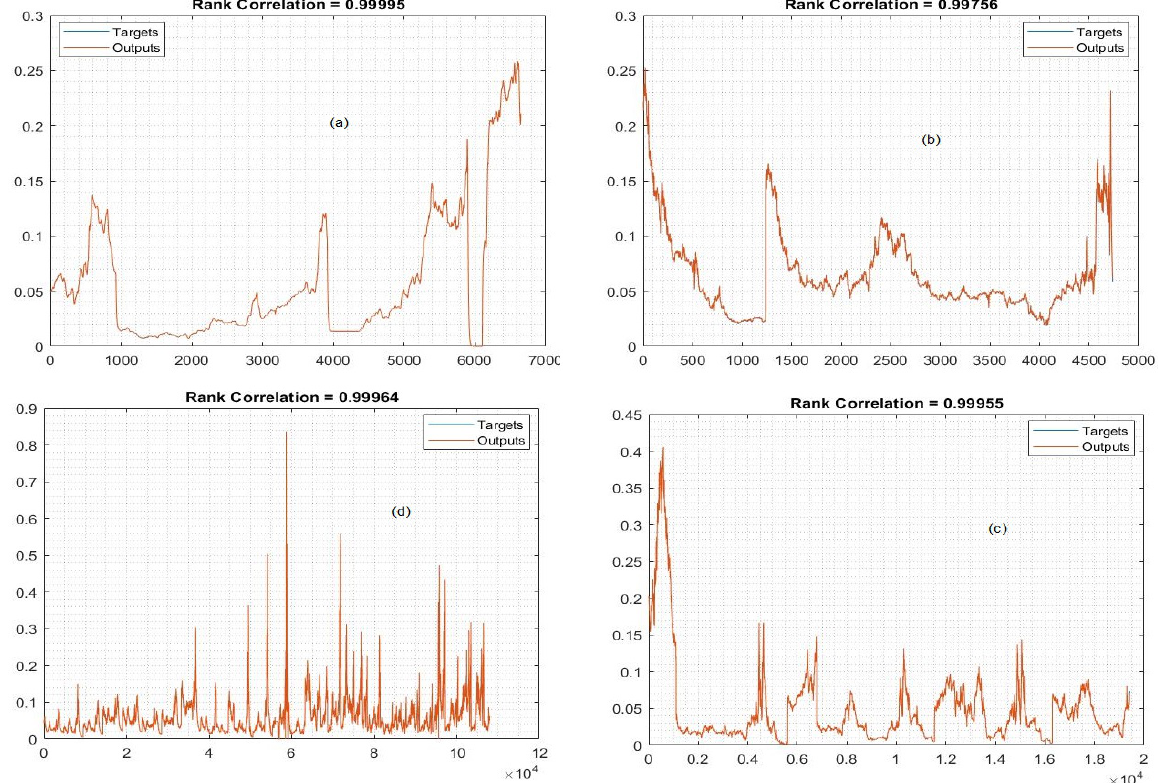
Figure 7. Prediction plot of the LSTM model in the testing process, ( a ) communication ( b ) energy, ( c ) financial and ( d ) industrial sectors.